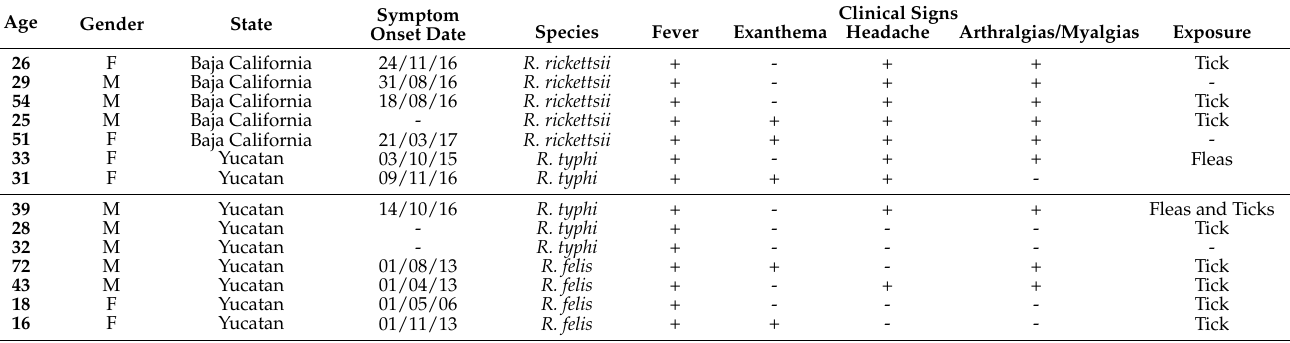
Table 1. Clinical characteristics of the